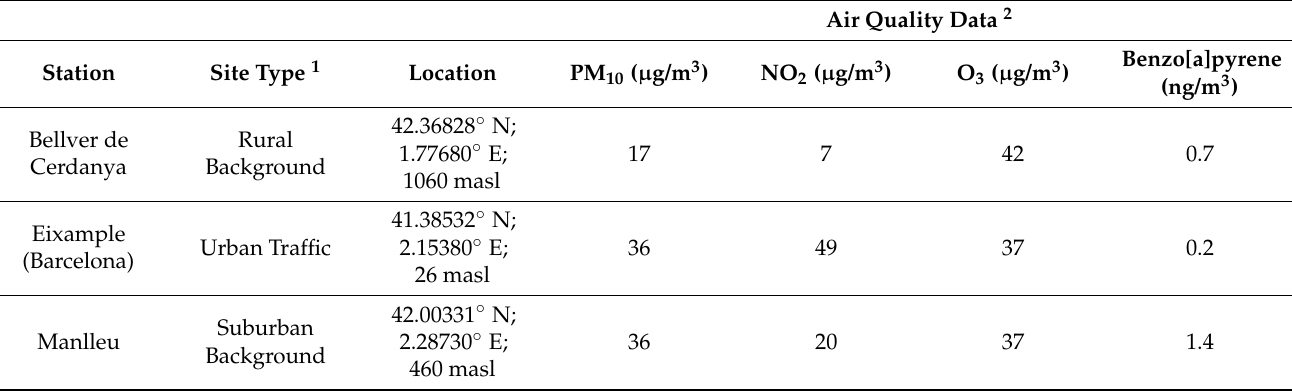
Table 1. Information of air quality stations and air quality